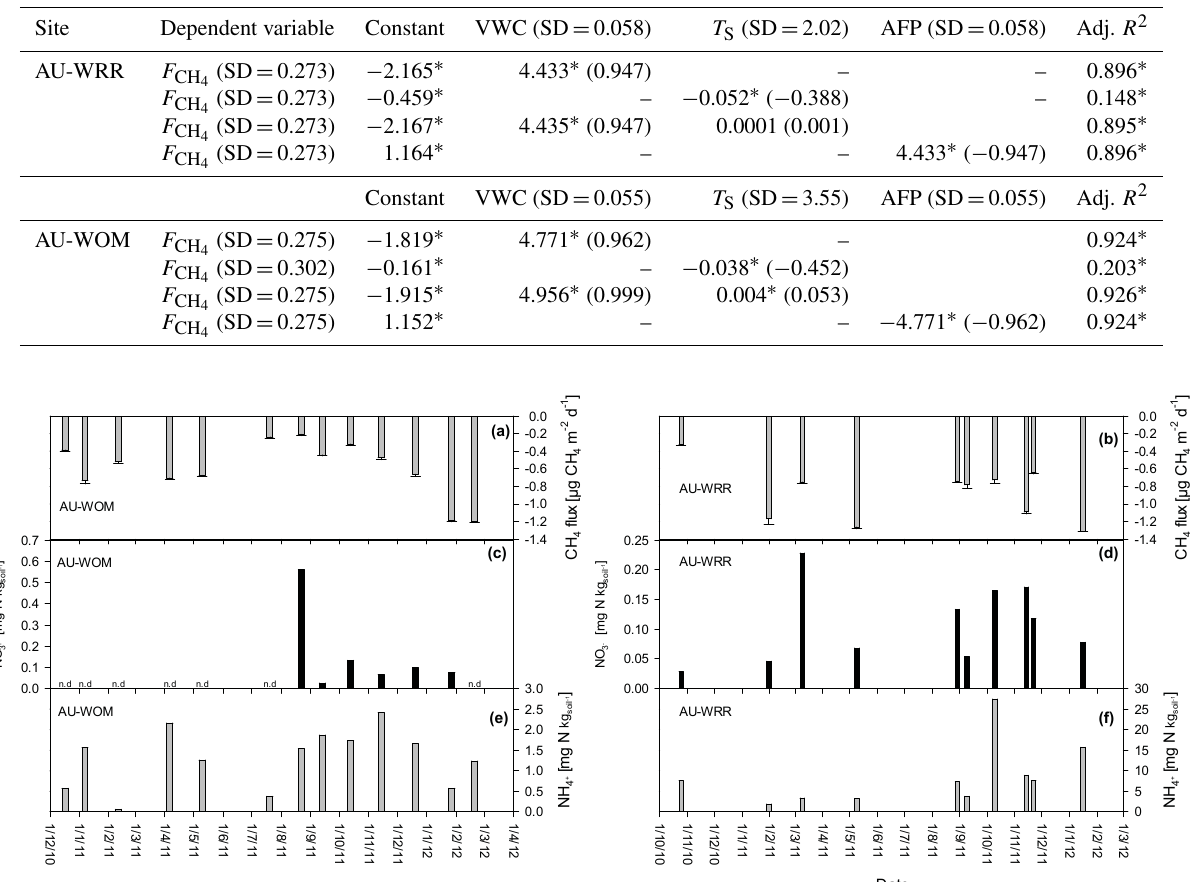
or NO − for both sites are not presented. 4 3 / CH 4 (Adj. R 2 = − 0 . 08, p = 0 . 83); AU-WRR: NO − / CH 4 (Adj. 4 3